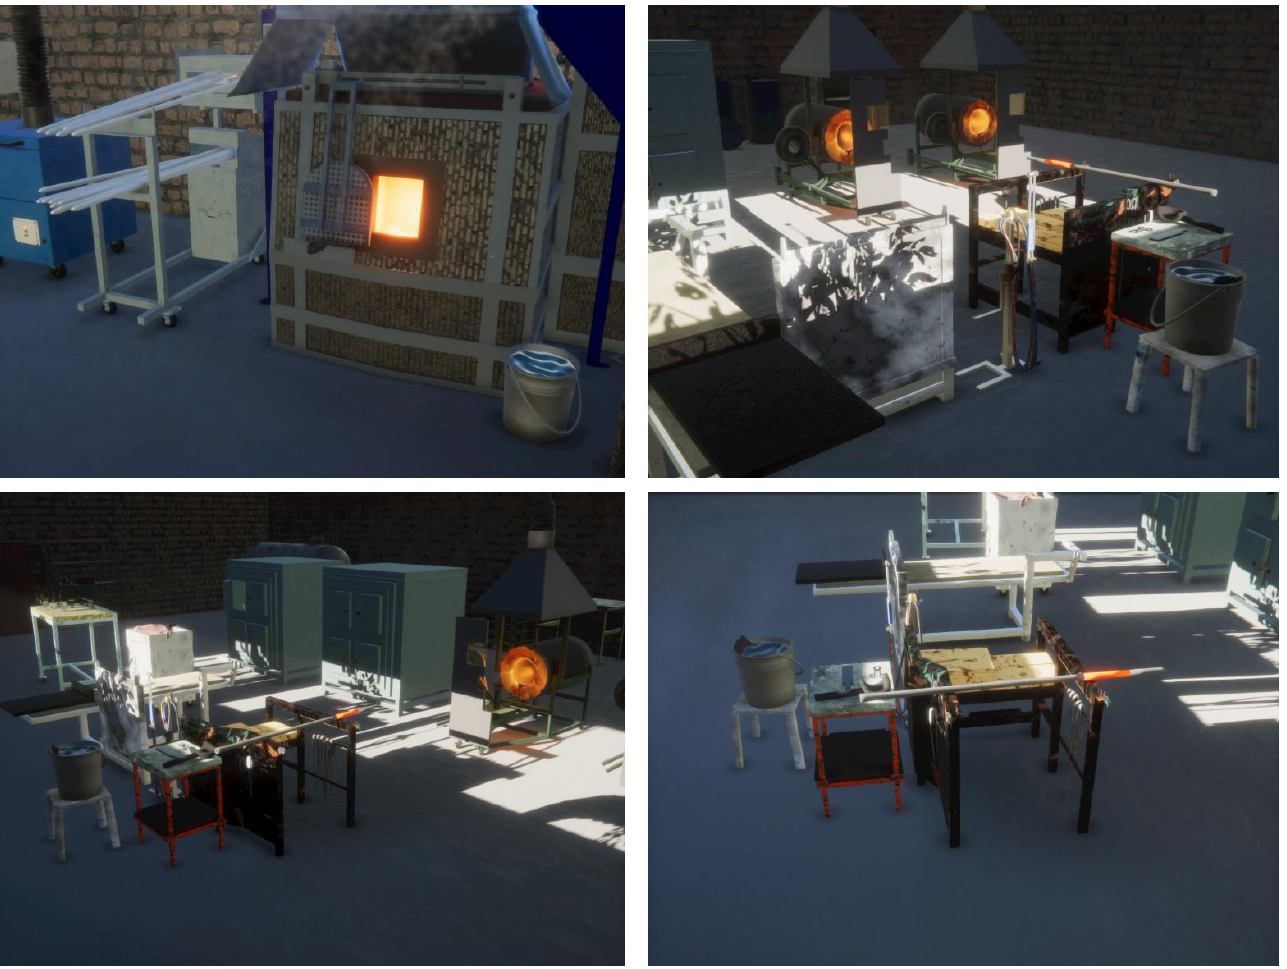
Figure 21. Presentation instances of the glass workshop application for educational purposes.